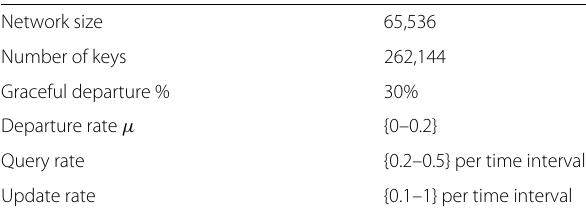
Table 4 Simulation parameters 2